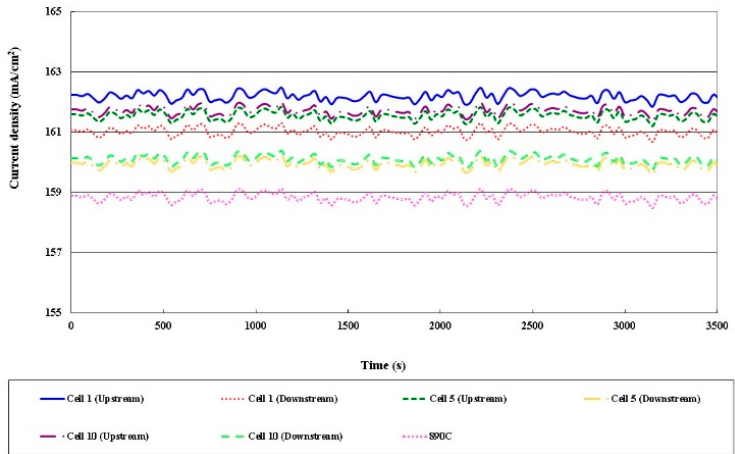
Figure 14. Comparison of local current densities in different cells (part of 5 A).